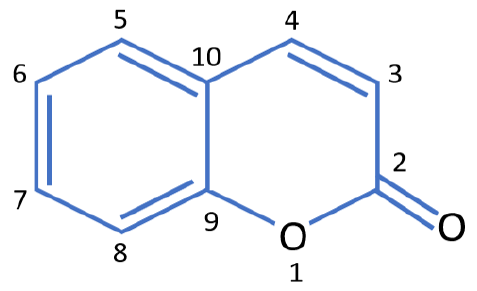
Figure 1. Structure of coumarin (1,2-benzopyrone).